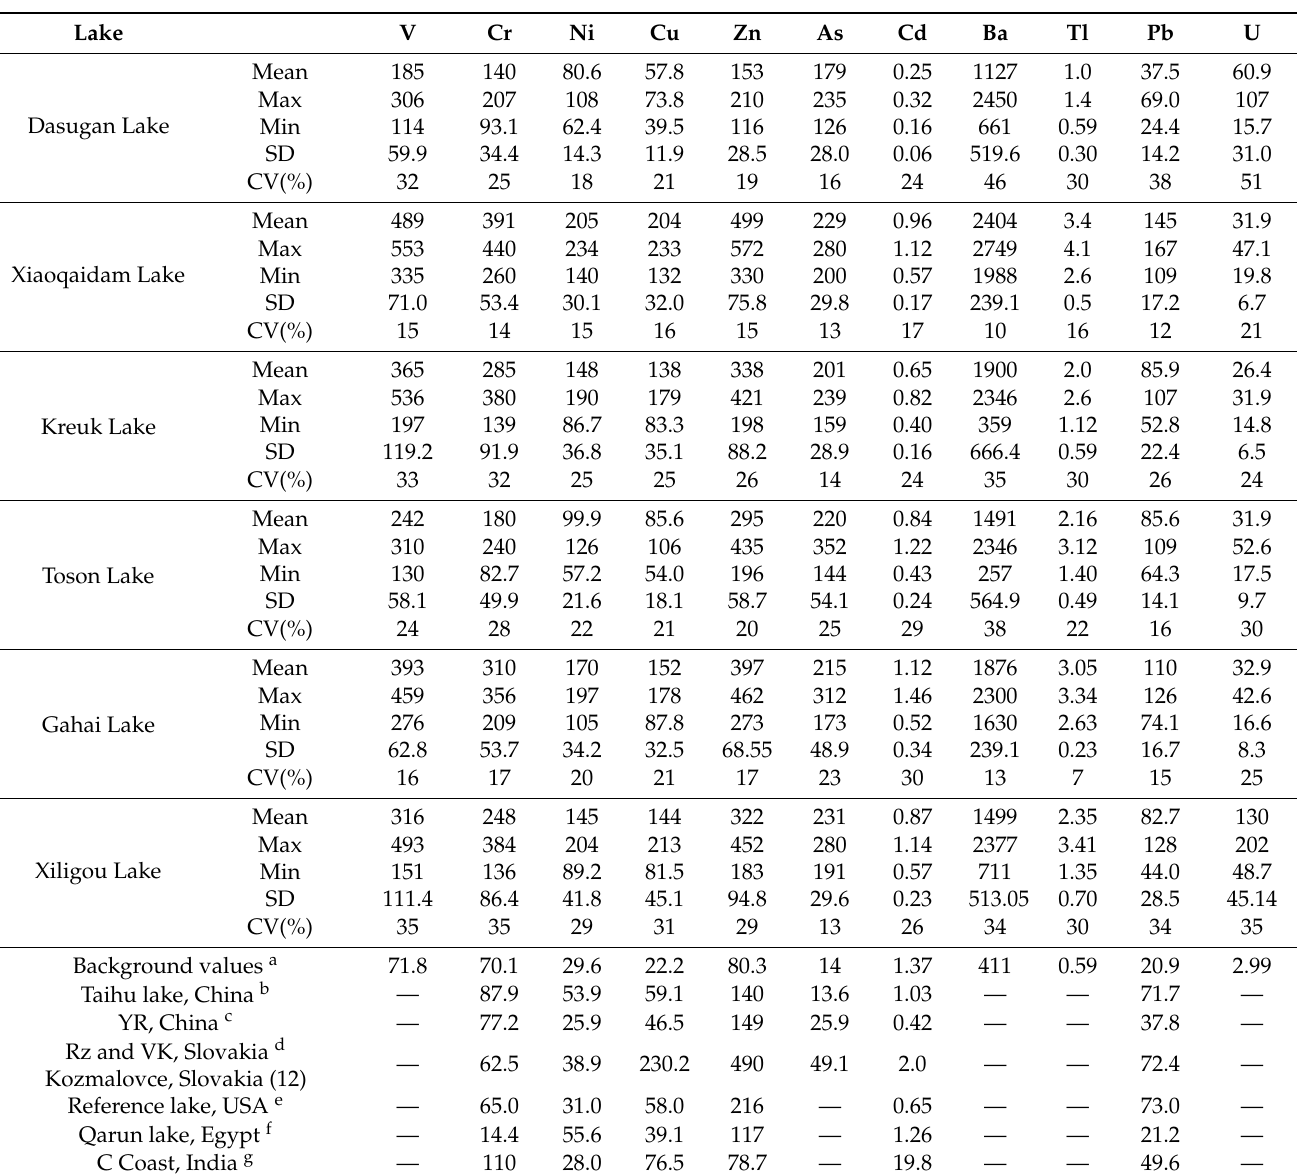
Table 1. Summaries of trace element concentrations (mg/kg) in sediments, background values (mg/kg) in the study area and comparison with other selected water systems around the world